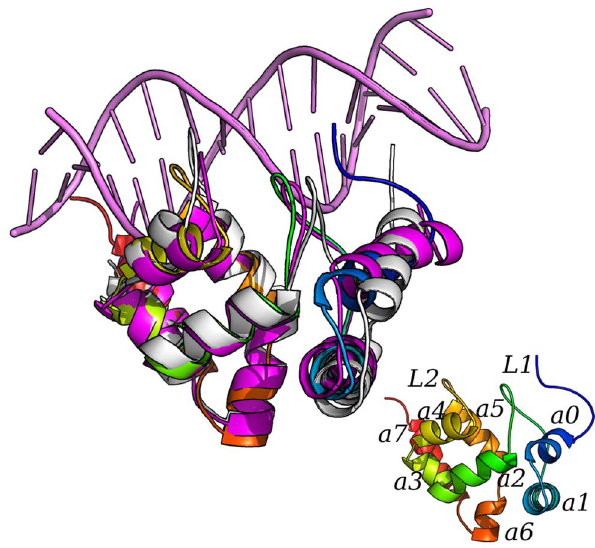
Figure 1. Target proteins and structural features. The 3D structures of ARID3A FREE (PDB entry 2KK0), Dri FREE (PDB entry 1C20) and Dri-DNA (PDB entry 1KQQ) are shown as yellow, light grey and magenta cartoons, respectively. In the figure at the bottom on the left the structure is colored with different shade of colors from the N- (blue) to the C-terminal extremity (red) and the secondary structural elements are labelled according to ref. [6]. In particular, a 0– a 7 (residues 231–234, 239–254, 272–282, 285–291, 294–300, 310–321, 324–329, 335–346 in ARID3A or according to the PDB entry 2KK0 numbering 25–28, 33–48, 66–76, 79–85, 88–94, 104–115, 118–123, 129–140) and a very short b - harpin consisting of antiparallel strands b 1 and b 2 (residues 264–265 and 268–269 in ARID3A or according to the PDB entry 2KK0 numbering 58–59 and 62–63) are shown.